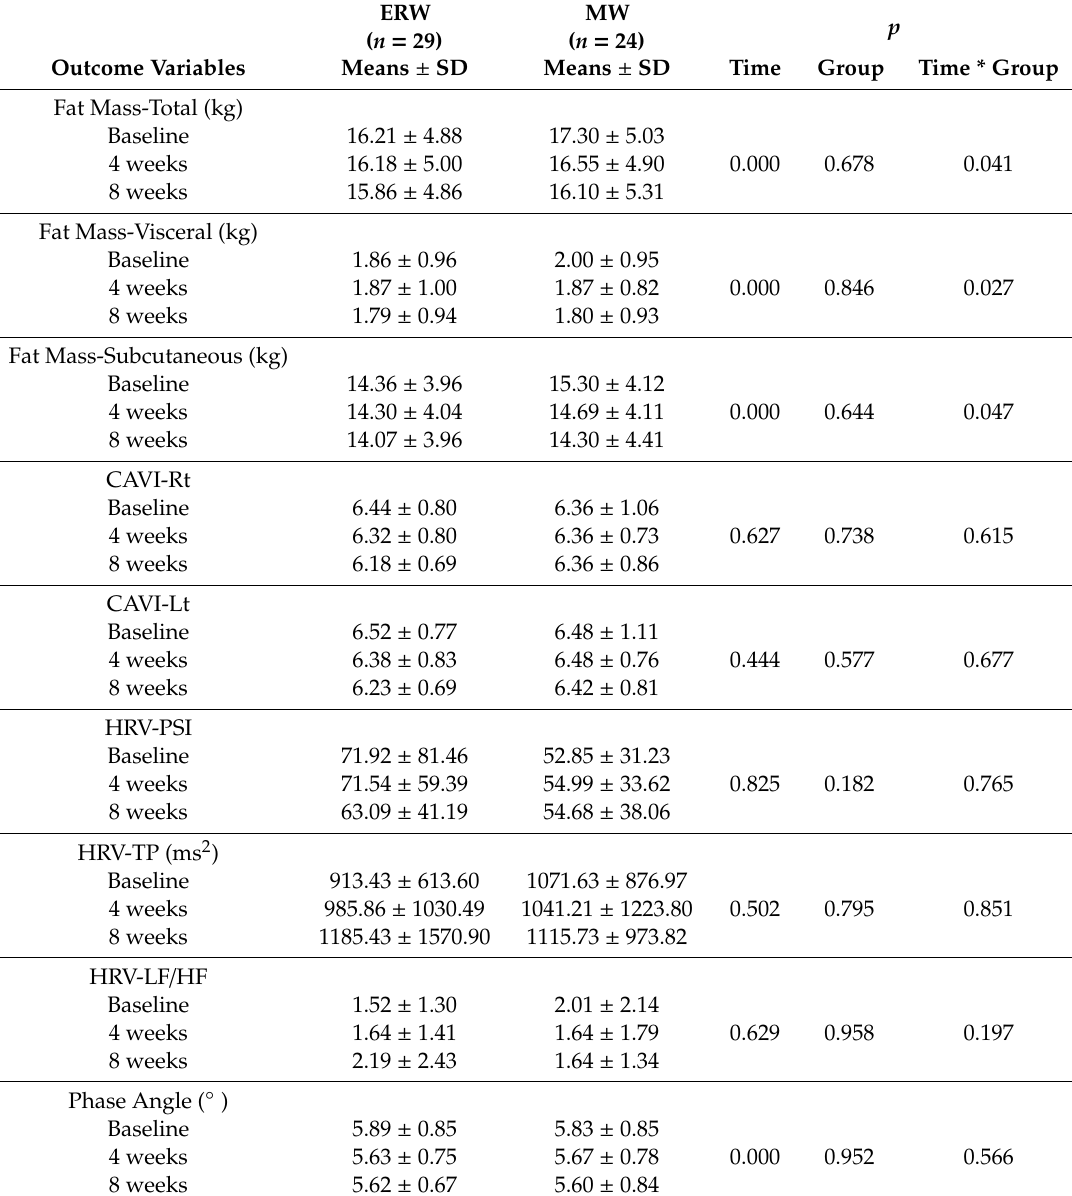
Table 4. E ff ects of treatment on the secondary outcome variables: fat mass, CAVI, HRV, and